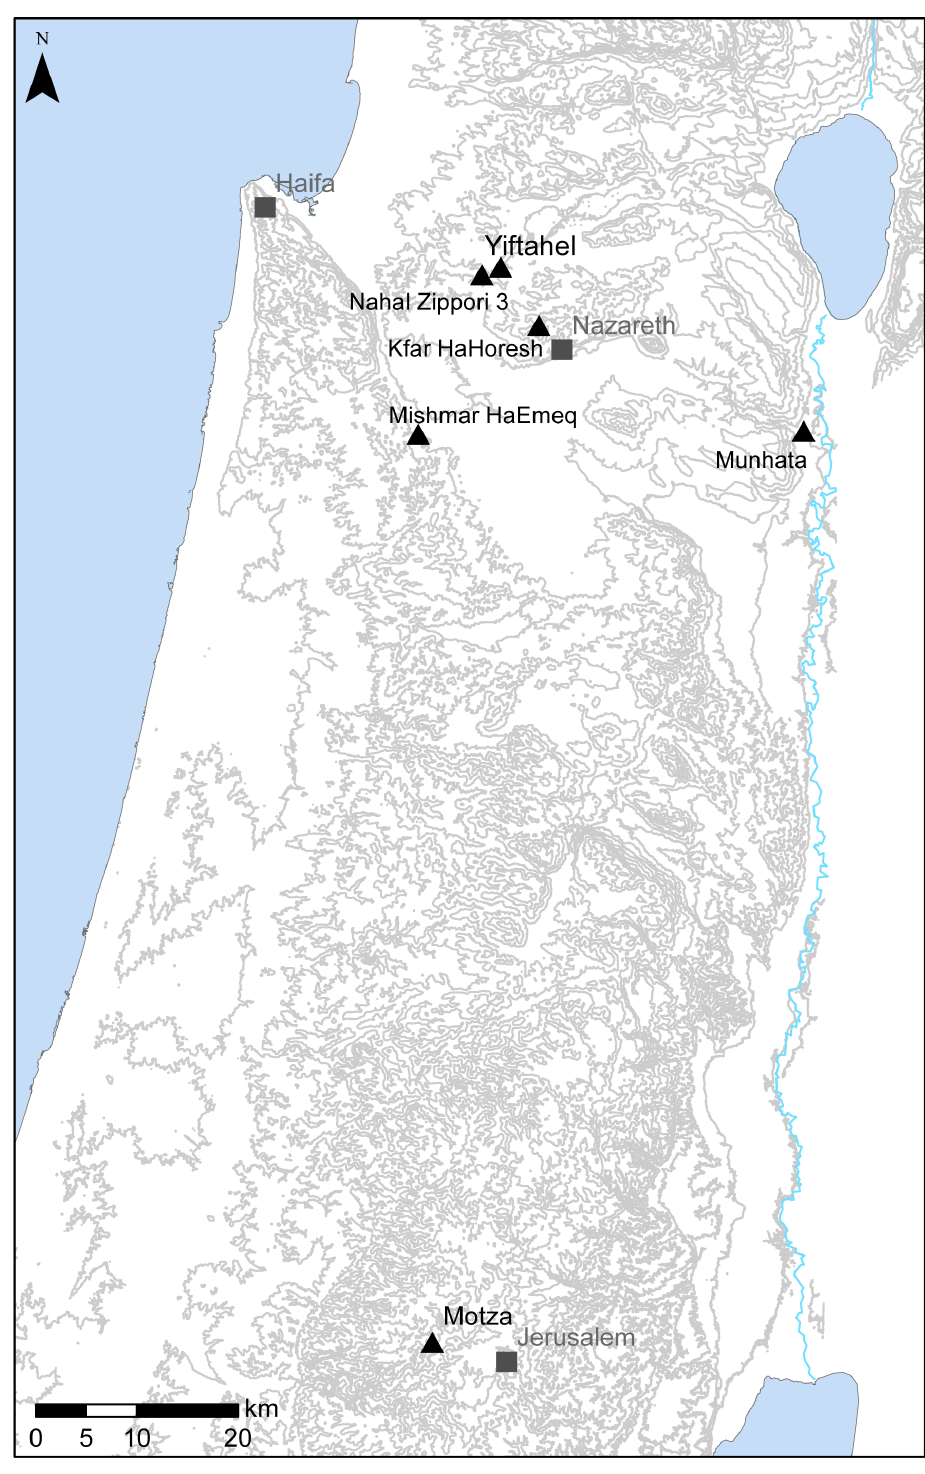
Fig 1. Location of Yiftah ’ el and Motza.